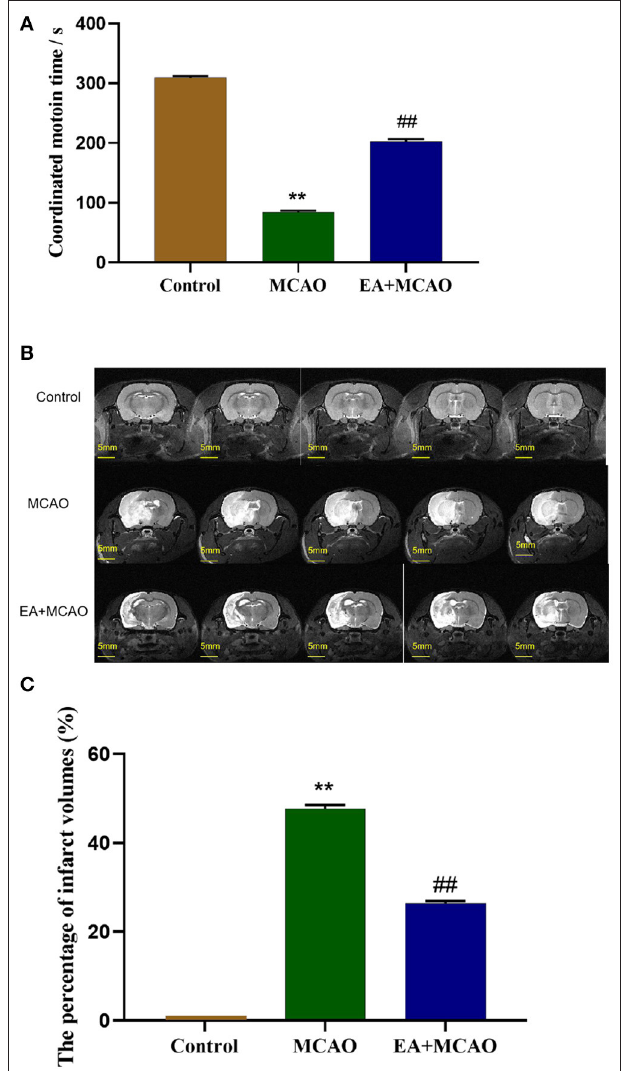
FIGURE 1 | Coordinated motion time and cerebral infarction volume of rats in each group. (A) The coordinated motion time of rats in each group on the 7th day. (B,C) Evaluation of cerebral infarction volume of rats in different groups by 9.4T MRI T2-weighted imaging and analysis. Results are expressed as means ± SEM ( n = 12, n = 3). ** P < 0.01, compared with the Control group; ## P < 0.01, compared with the MCAO group.